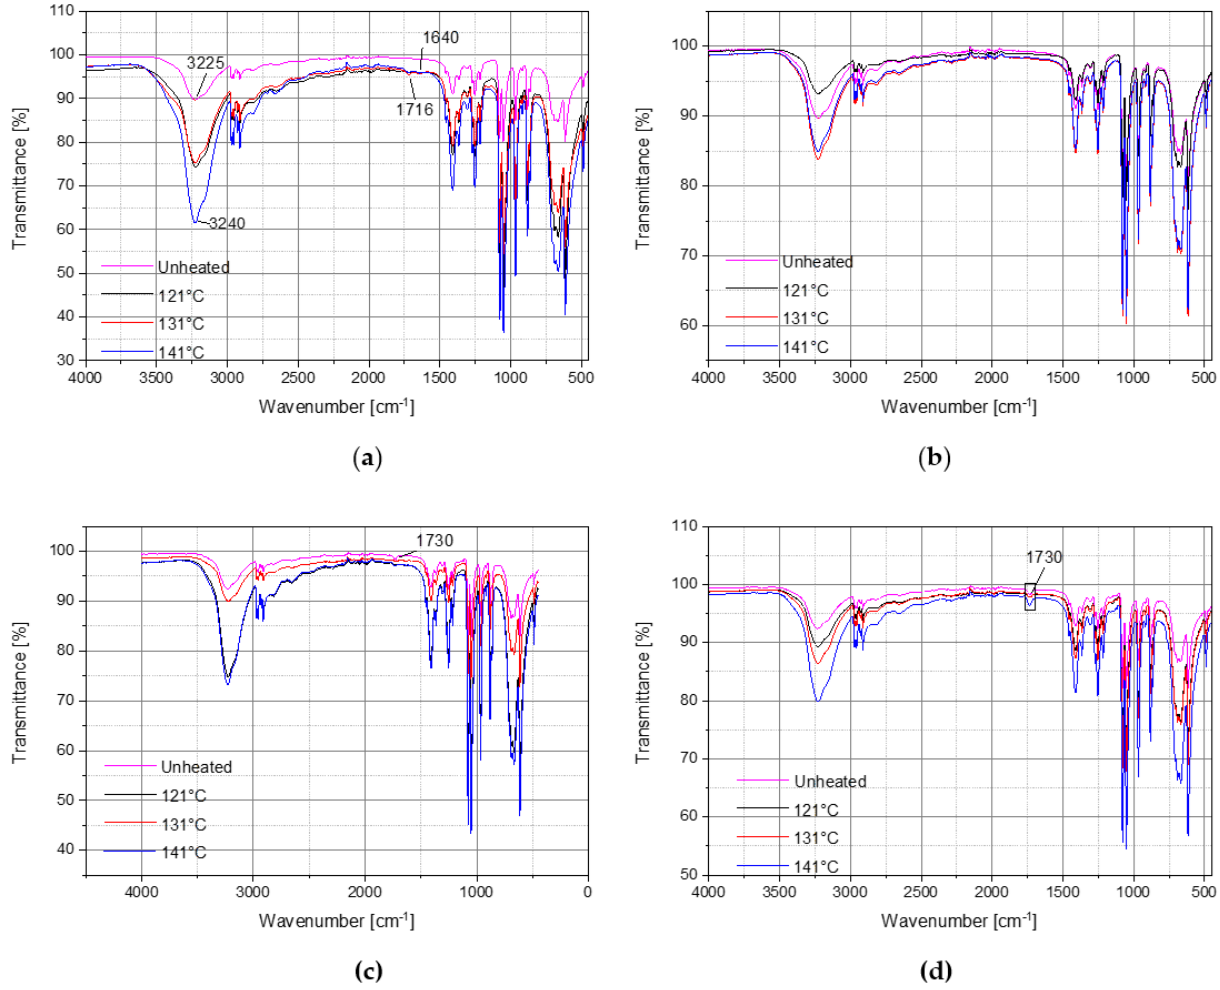
Figure 10. FT-IR spectra of the short-term-tests for ( a ) pure erythritol under air; ( b ) pure erythritol under argon atmosphere; ( c ) erythritol with antioxidant under air and ( d ) erythritol with antioxidant under argon atmosphere.